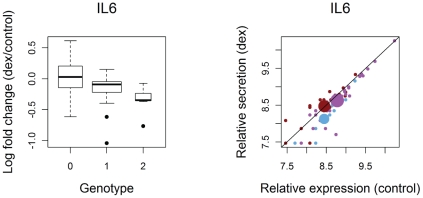
Secretion QTL for IL6.Genotype is coded as copies of the minor allele. Log fold change in secretion corresponds to the difference between dex and control of covariate-corrected, quantile-normalized, log2-transformed estimates of relative quantity from ELISA assays. In plot on the right, each small dot corresponds to an individual and is color-coded based on genotype (red = homozygous for major allele, purple = heterozygous, and blue = homozygous for minor allele). Large dots represent genotypic means.